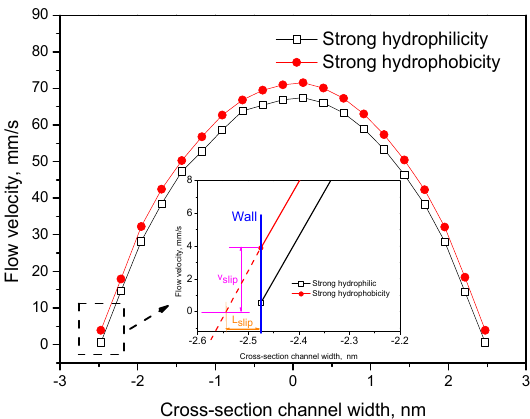
Figure 6. Velocity curve under di ff erent wetting conditions at external pressure F g = 2 MPa. 𝑉 (cid:3046)(cid:3039)(cid:3036)(cid:3043) is zero mainly because when the molten polymer passes through the strong hydrophilic